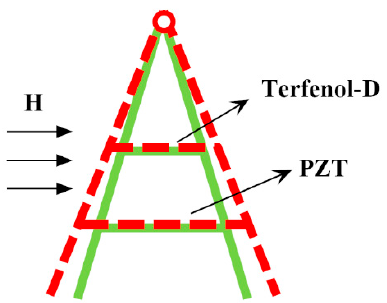
Figure 2. The working principle of A-line shape ME structures.